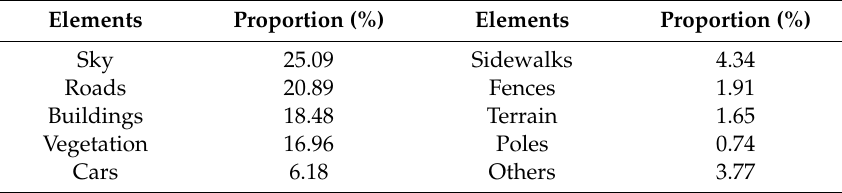
Table 3. Proportion of street view elements in the study